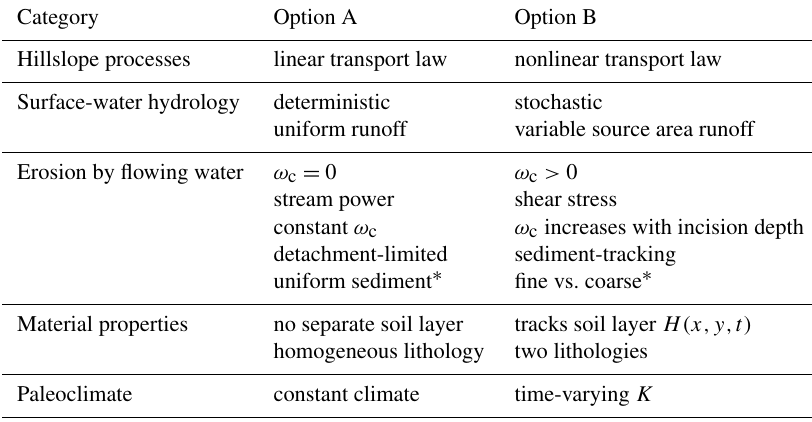
Table 1. Model program binary options.